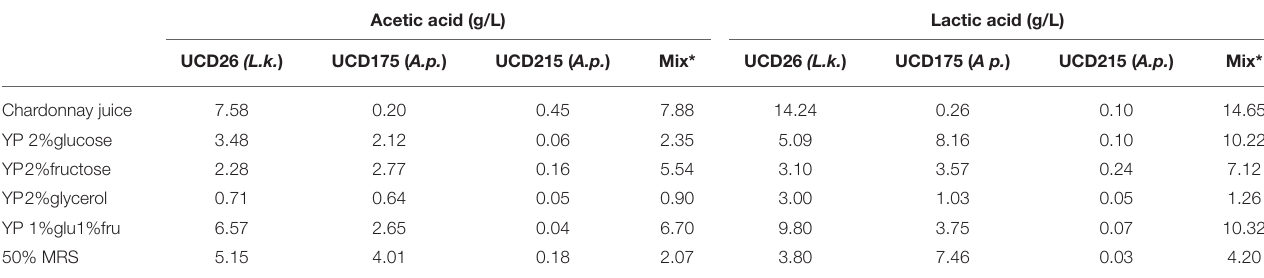
TABLE 4 | Production of acetic and lactic acids by inhibitory Acetobacter pasteurianus (UCD215) and inducing, Lactobacillus kunkeei (UCD26) and Acetobacter pasteurianus (UCD175) and with a mixture of strains 26 and 175 after 48 h of growth in the target medium. Acetic acid (g/L) Lactic acid (g/L) UCD26 (L.k. ) UCD175 ( A.p. ) UCD215 ( A.p. ) Mix* UCD26 (L.k. ) UCD175 ( A p. ) UCD215 ( A.p. ) Mix* Chardonnay juice